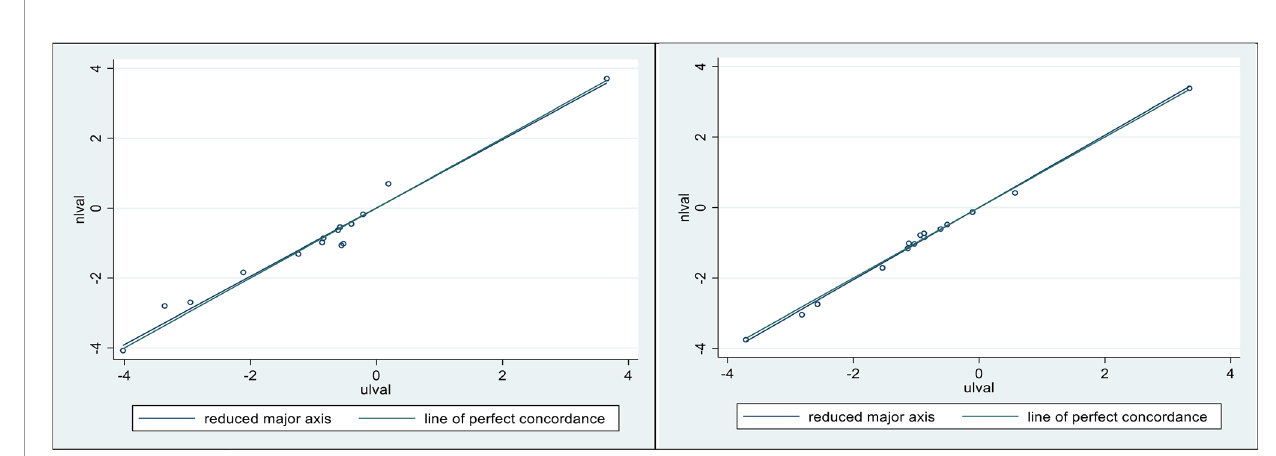
FIGURE 6 | Lin ’ s concordance correlation coef fi cient (CCC) was 0.98 ± 0.05 for horse 1 (Left), and 0.997 ± 0.001 for horse 5 (Right). Plotted sloping lines represent estimated concordances (identi fi ed as the reduced major axis) and a line of perfect concordance, passing, as nearly as possible, through all pairs of